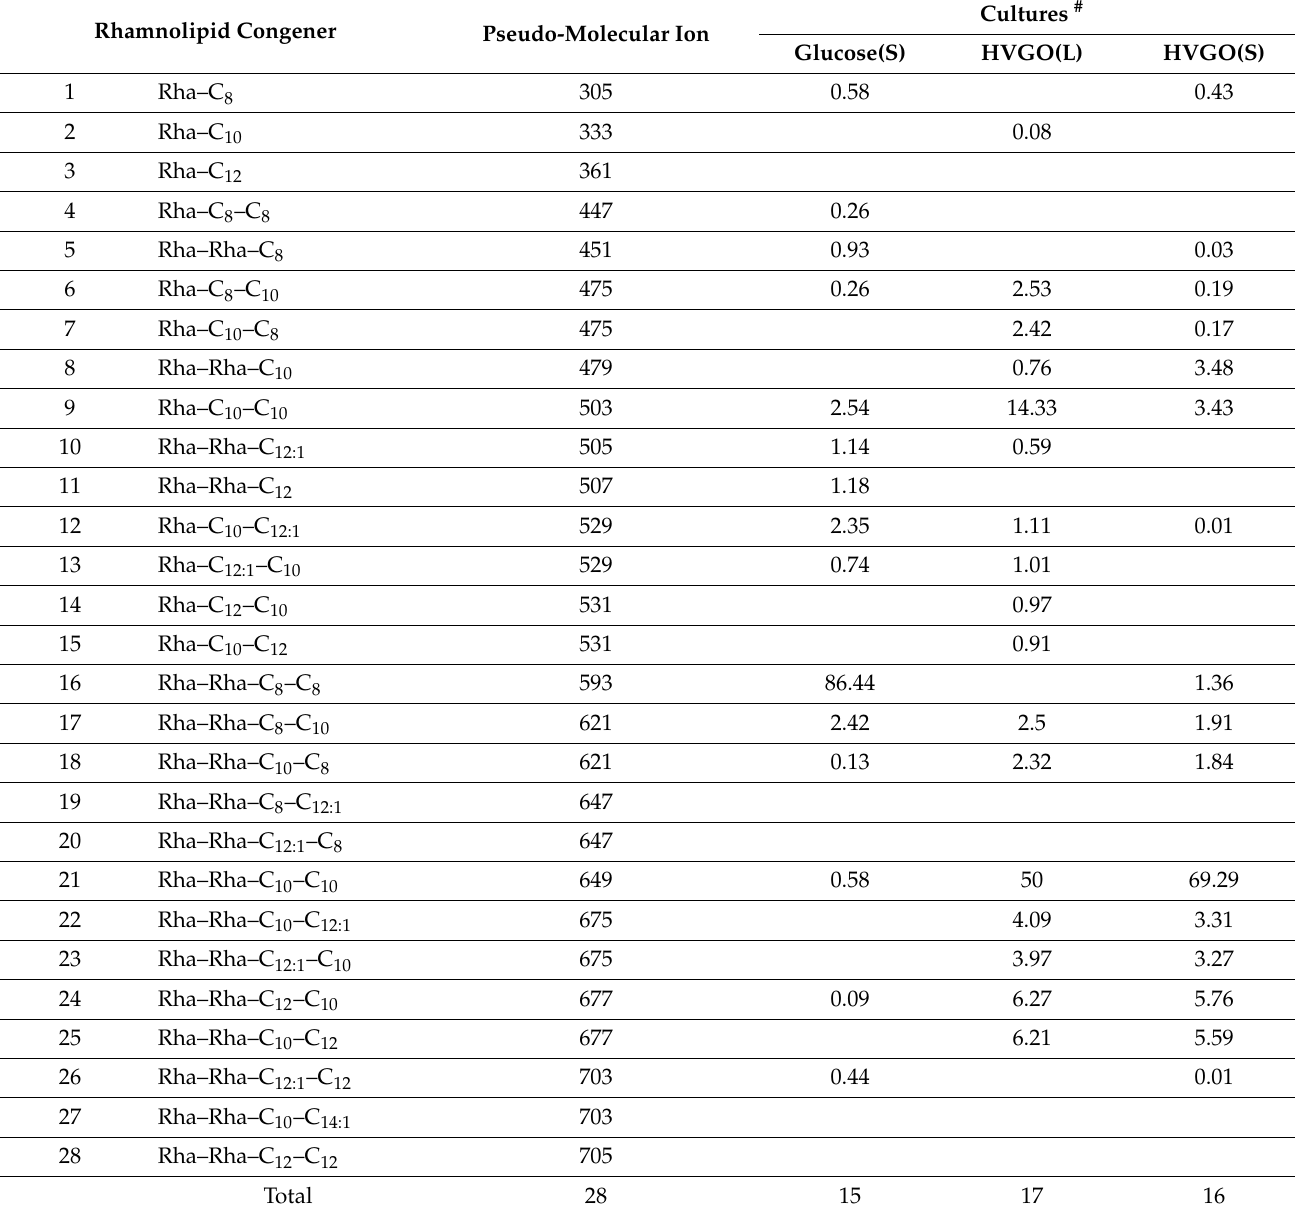
Table 2. Relative abundance (%) of rhamnolipid congeners produced in glucose and HVGO cultures of the AK6U strain. Rhamnolipid Congener Pseudo-Molecular